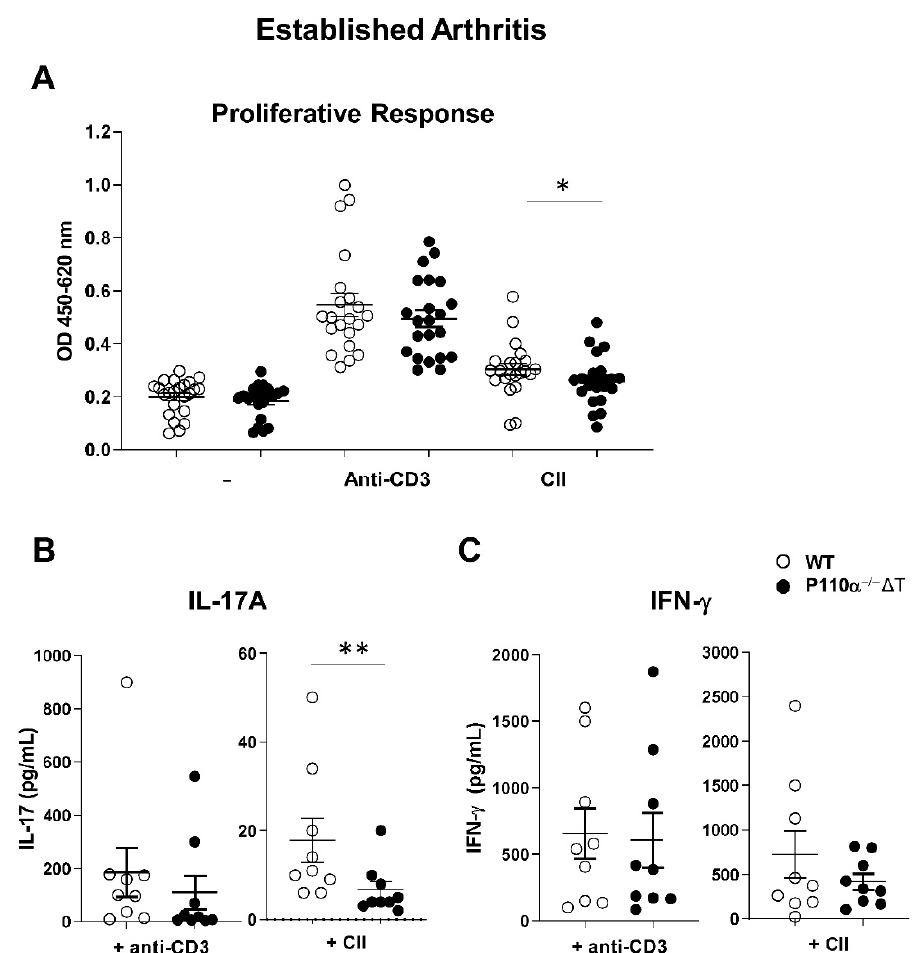
Figure 3. Analysis of proliferative and effector response in lymph node cells of p110 α − / − Δ T mice under CIA (established arthritis). ( A ) The proliferative responses of lymph node cells from WT (white symbols) and p110 α − / − Δ T (black symbols) mice were measured with WST-1 assay after three days of in vitro stimulation with anti-CD3 Ab, antigen (Collagen II, CII) or vehicle (PBS, -) as indicated in the figure legend. Mice were individually analyzed ( n = 22 for each group) and cultures were set up in triplicates. Content of the cytokines IL-17A ( B ) and IFN- γ ( C ) in 48 h culture supernatants of lymph node cells stimulated by anti-CD3 or CII was measured by ELISA. * p < 0.05; ** p < 0.01. In ( B , C ), one representative experiment out of three is shown, in which n = 9 for WT and n = 9 for p110 α − / − Δ T. Data show the mean ± SEM from individual mice analyzed.